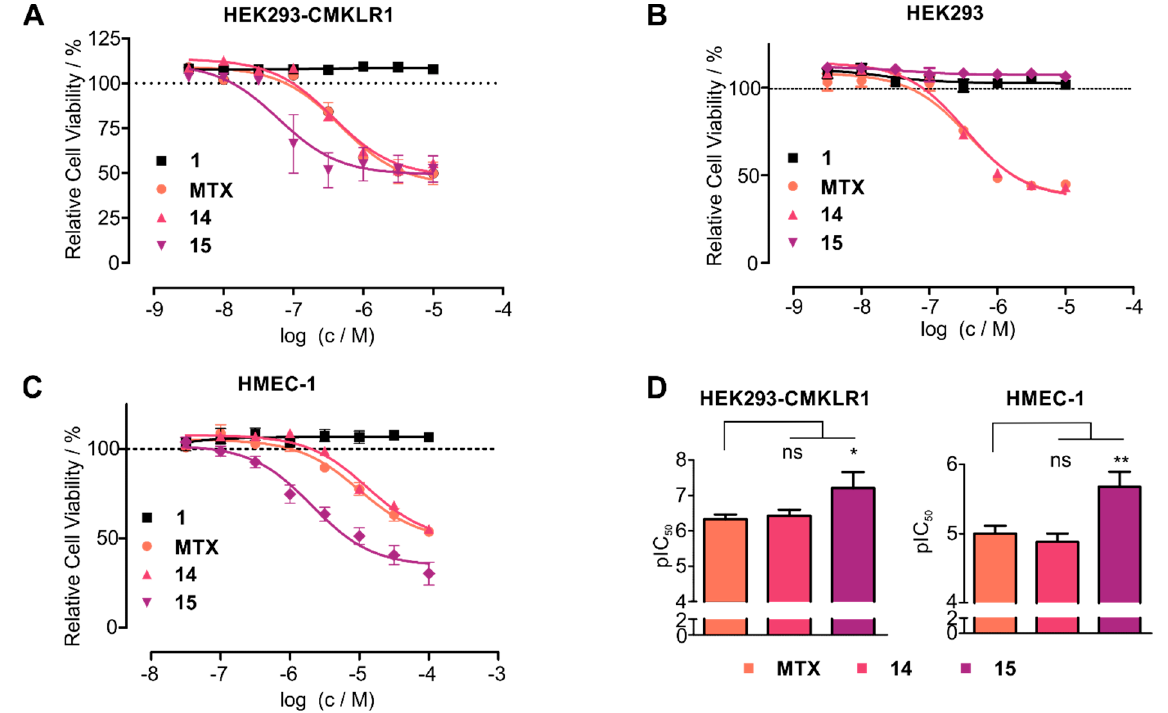
Figure 6. Cyclic chemerin-9 derivatives can shuttle MTX into CMKLR1-expressing cells. ( A ) Toxicity of MTX and MTX-modified chemerin-9 analogs on stably transfected HEK293-CMKLR1 were tested in a resazurin-based cell viability assay. Chemerin-9 ( 1 ) itself is not toxic, MTX and the MTX-modified linear peptide 14 demonstrate moderate toxicity. In contrast, the stabilized MTX-modified analog 15 demonstrates a significantly higher potency. ( B ) Toxicity of MTX and MTX-peptide conjugates on untransfected HEK293 cells. The stabilized conjugate 15 is not toxic at concentrations up to 10 µM, confirming the receptor-dependent toxicity of this conjugate. ( C ) Analog 15 displays superior toxicity compared to MTX alone or the linear conjugate 14 on endogenous CMKLR1-expressing HMEC-1 cells. Data points represent mean ± SEM from at least three independent experiments performed in duplicates. ( D ) Statistical analysis of pIC 50 values of MTX and analogs 14 and 15 on HEK293-CMKLR1 and HMEC-1 cells, bars represent mean ± SD. On both cell lines, 15 is significantly more toxic than free MTX (* p < 0.05, ** p < 0.01, ns: not significant, p > 0.05 in a one-way ANOVA with Dunnett’s post test).